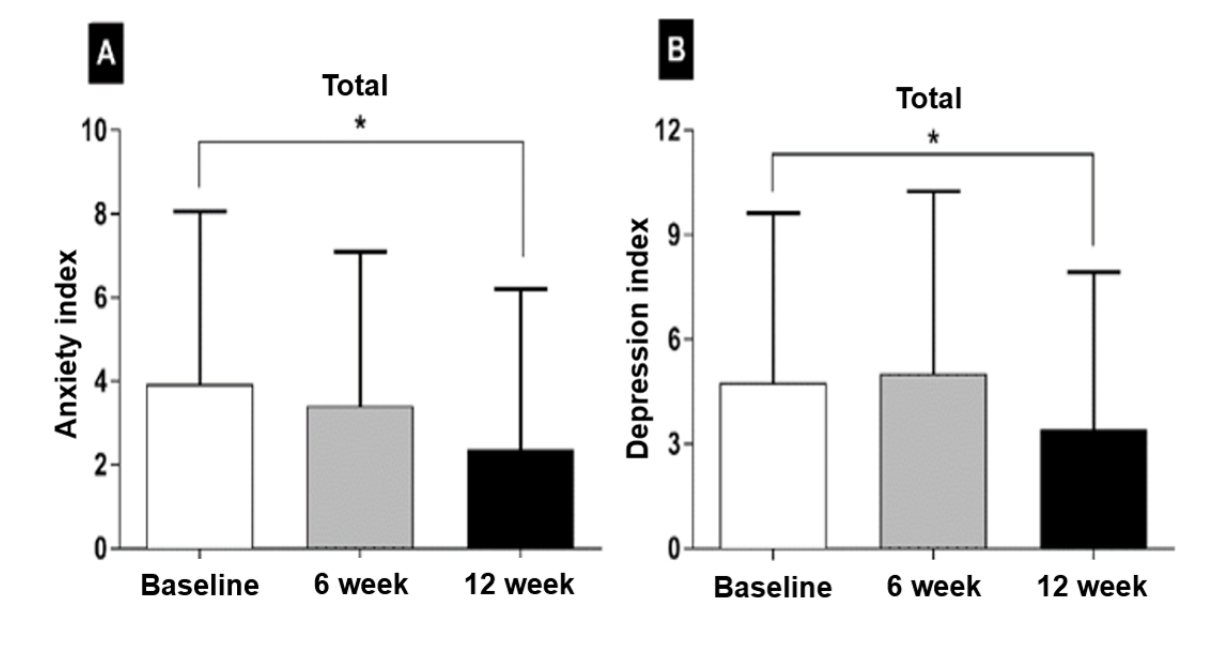
Figure 3. Distress indexes. Anxiety (A) and depression (B) significantly improved after pulmonary